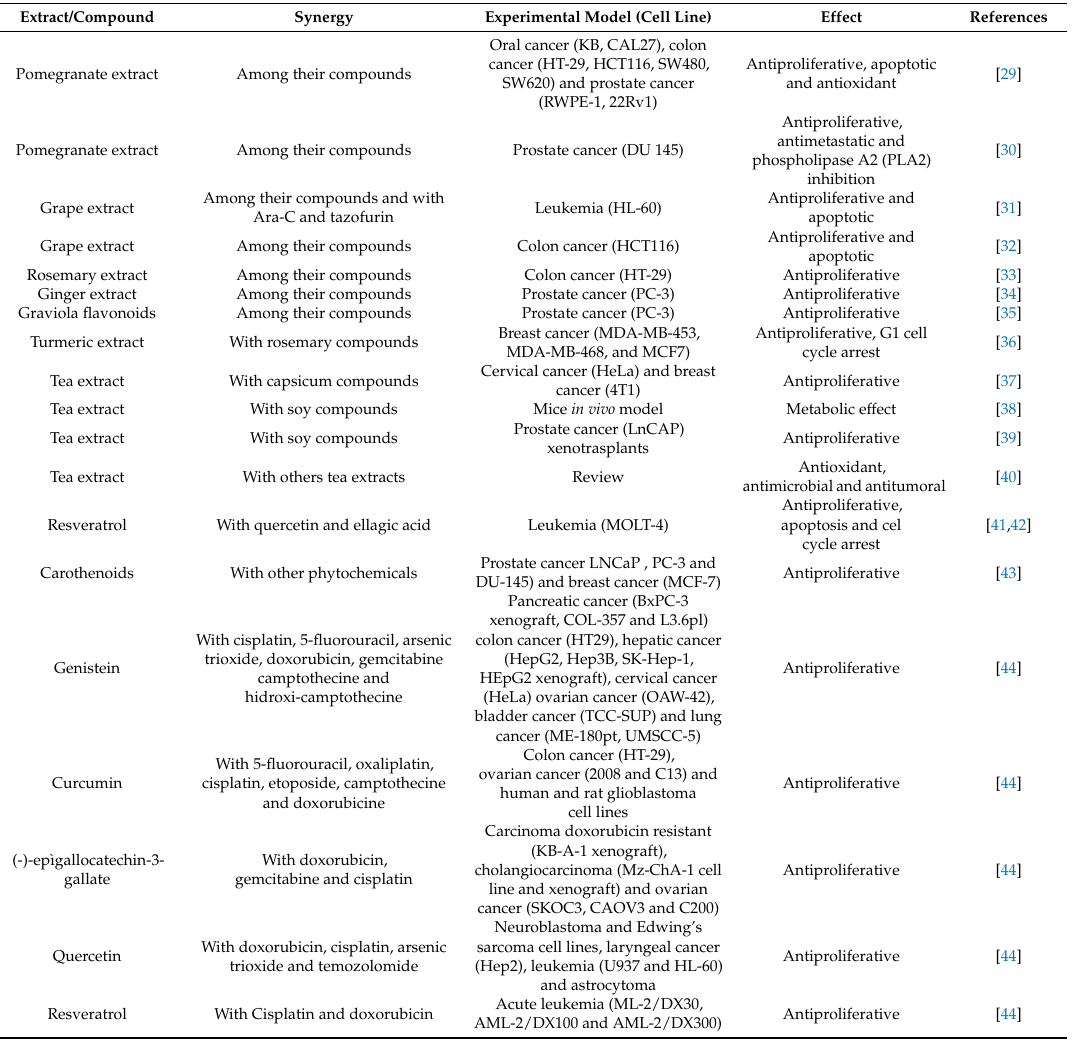
Table 1. Examples of synergic interactions among compounds or compounds and approved drugs in cancer research. Main examples included in this manuscript are shown in this table, organized in rows. First and second columns indicate the name of the components among which synergy is obtained. Third and fourth and fifth columns show the cellular models in which synergy studies were performed (including their origin), the main effect and the bibliographic